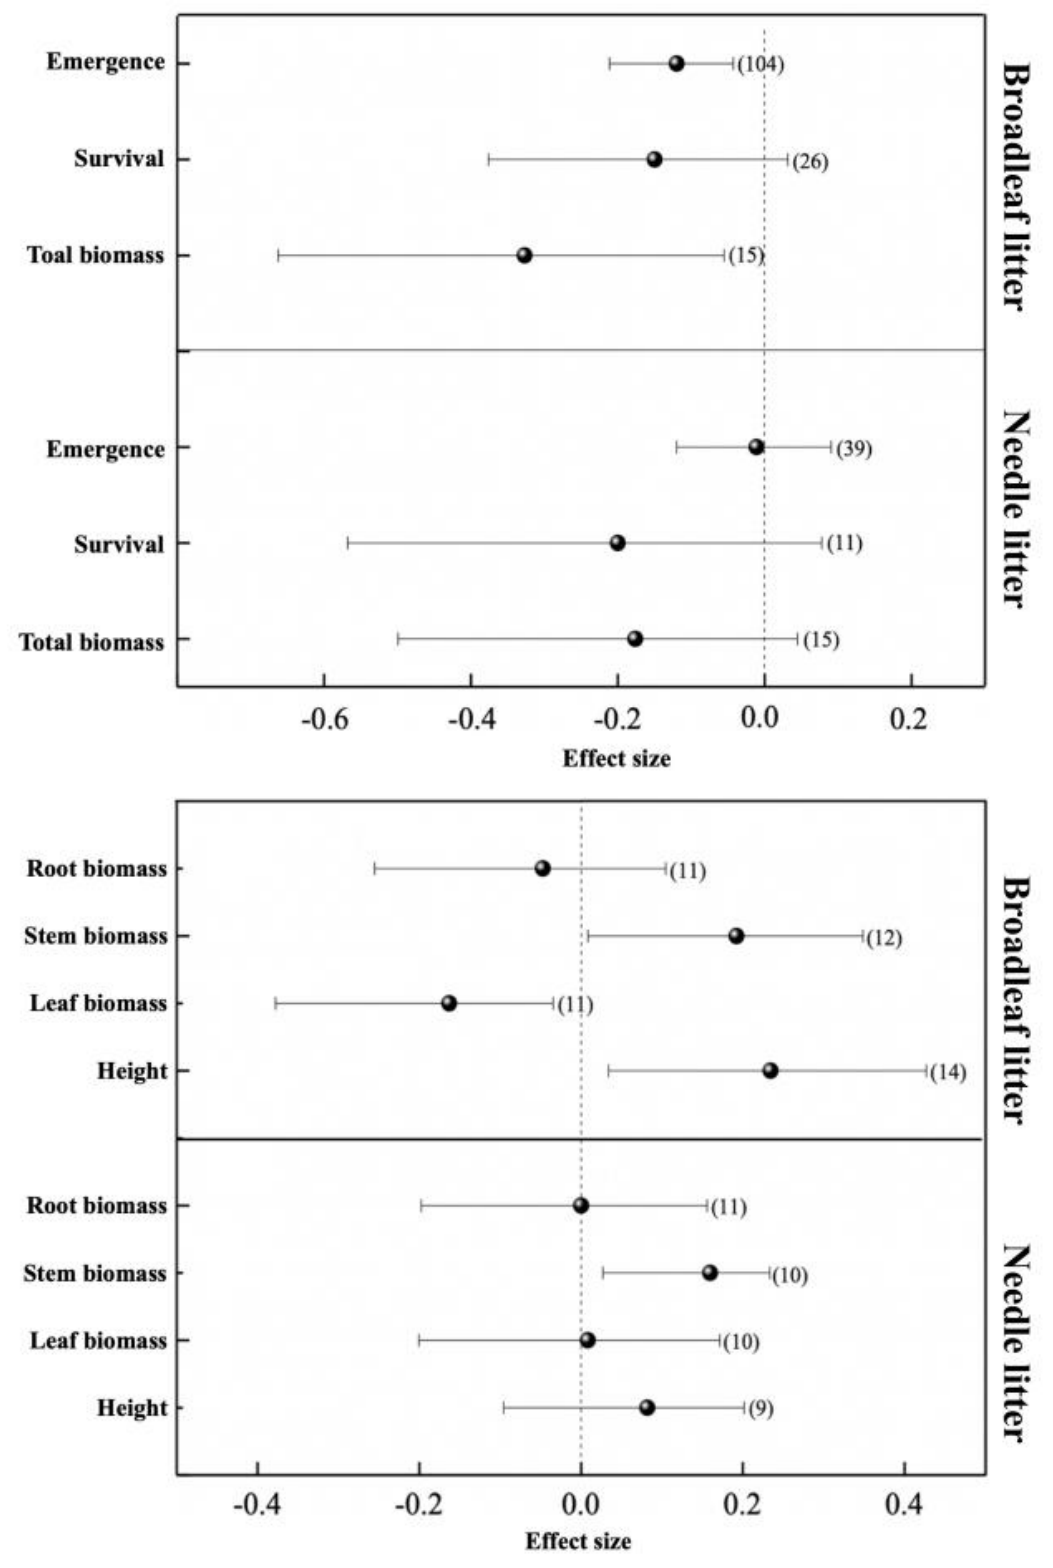
Figure 3. Mean effect size for seedling emergence, survival, total biomass, root, stem, leaf biomass, and height under broadleaf litter and conifer needle litter cover. Error bars represent 95% CIs. The numbers in brackets represent the sample size of each indicator.